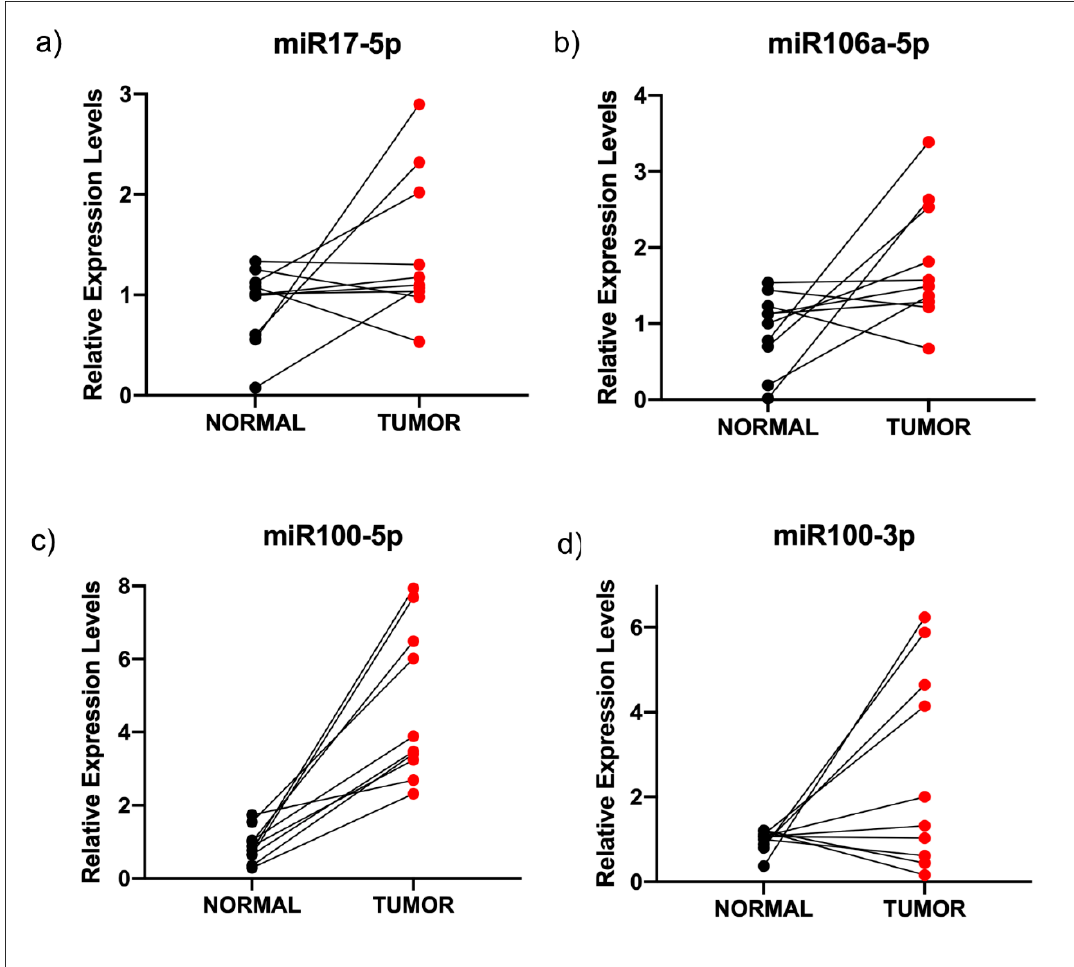
Figure 4. Relative expression of miRNAs in ten matched normal and carcinoma samples. Relative expression of miR ‐ 17 ‐ 5p ( a ), miR ‐ 106a ‐ 5p ( b ), miR ‐ 100 ‐ 5p ( c ) and miR ‐ 100 ‐ 3p ( d ). As observed, only miR100 ‐ 3p and ‐ 5p were overexpressed in tumor samples.